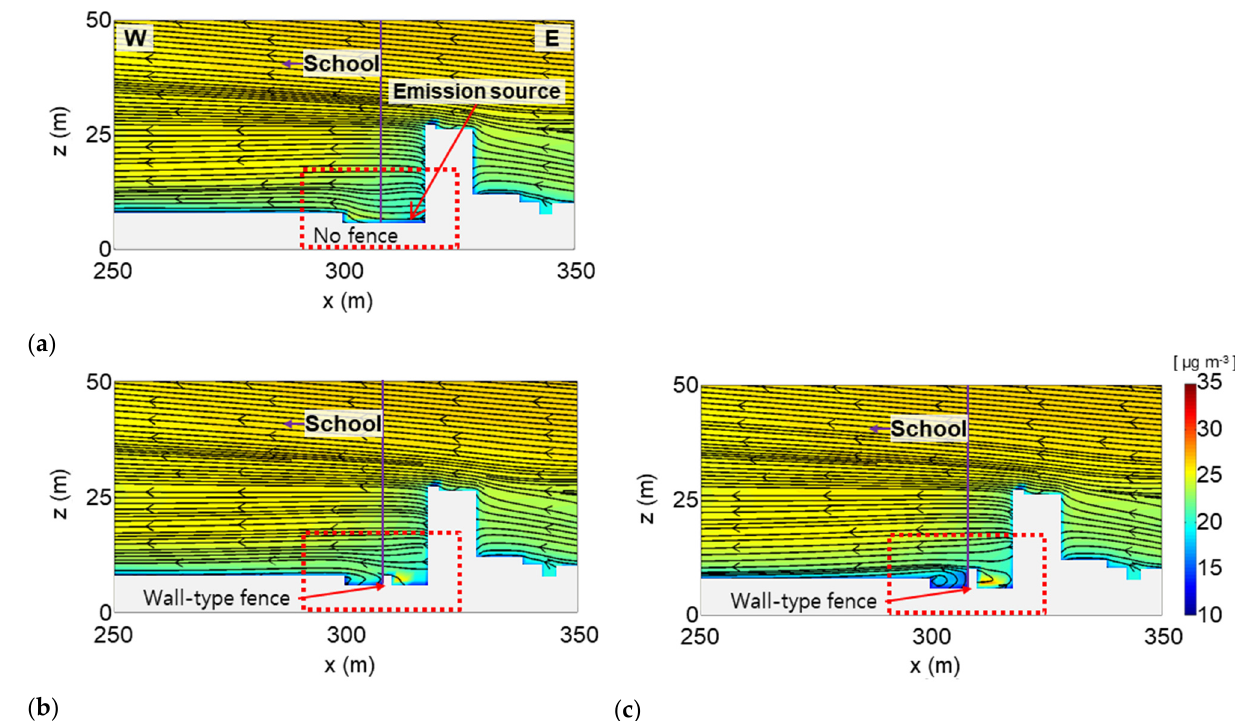
Figure 7. Streamlines and PM 2.5 concentrations in the vertical plane of y = 230 m for the east–southeasterly inflow direction in the ( a ) CNTL, ( b ) W2M, and ( c ) W4M cases.